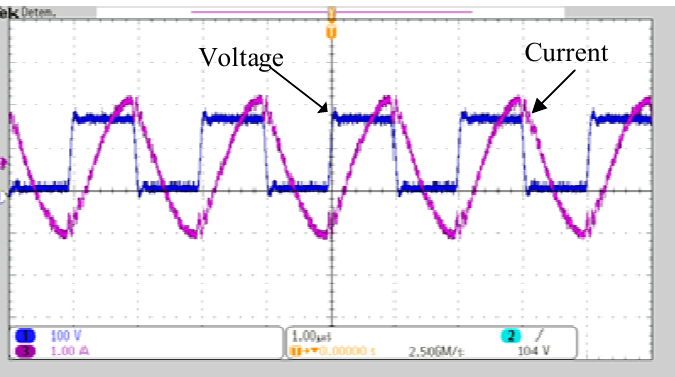
Figure 20. Waveforms: input current (purple, 200 mA/div), input voltage (blue, 100 V/div).